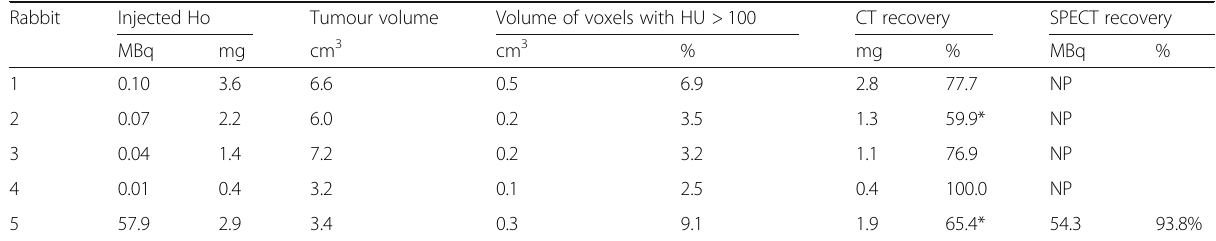
(SPECT) and computed tomography (CT) Rabbit Injected Ho Tumour volume Volume of voxels with HU > 100 CT